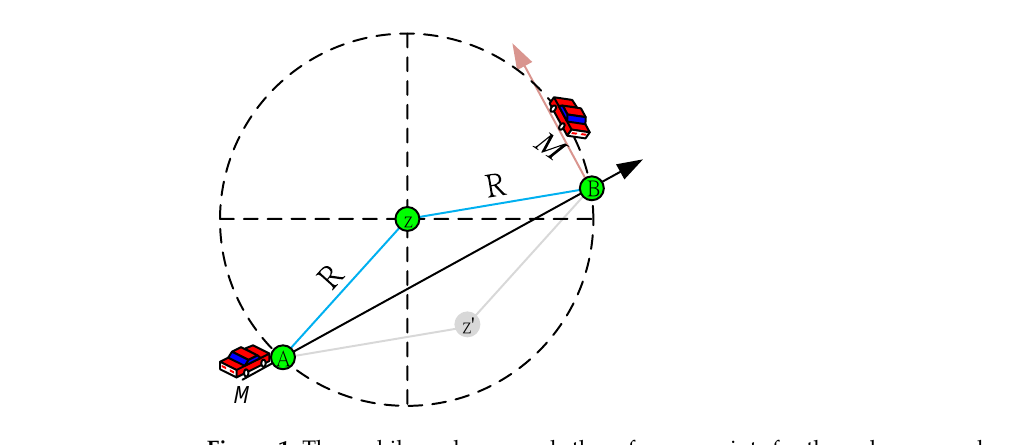
Figure 1. The mobile anchor records the reference points for the unknown node z.